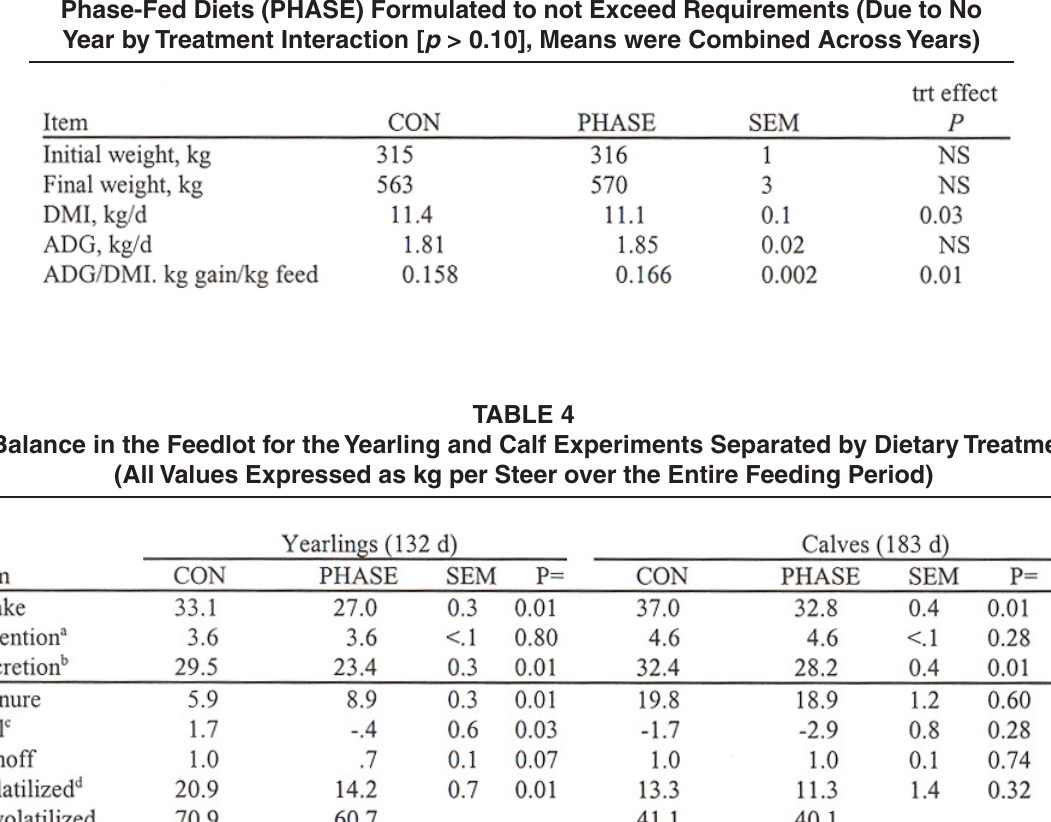
Performance of Yearlings Fed either Conventional Protein (CON) or Phase-Fed Diets (PHASE) Formulated to not Exceed Requirements (Due to No